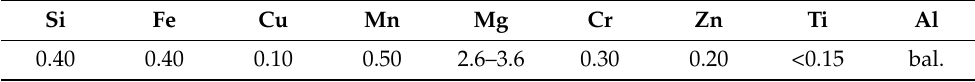
Table 1. Chemical composition of the workpiece material reproduced from [28].